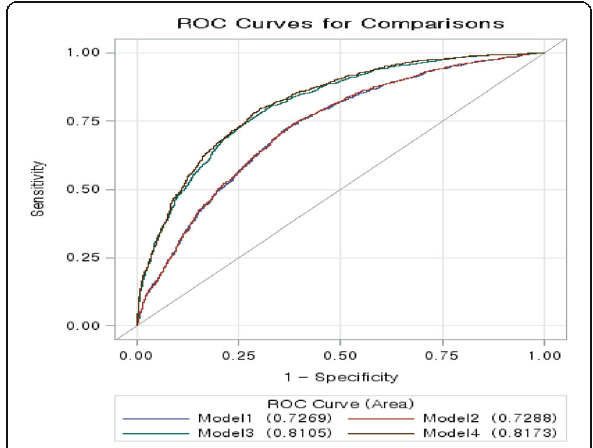
Fig. 2 ROC curve (area) according to the models. Model 1 was adjusted for age, sex, body mass index, education, income, smoking, drinking, and physical activity; Model 2 was further adjusted for total cholesterol and C-reactive protein; Model 3 was additionally adjusted for fasting glucose, HDL cholesterol, triglyceride levels, and systolic and diastolic blood pressures; Model 4 was further adjusted for SC